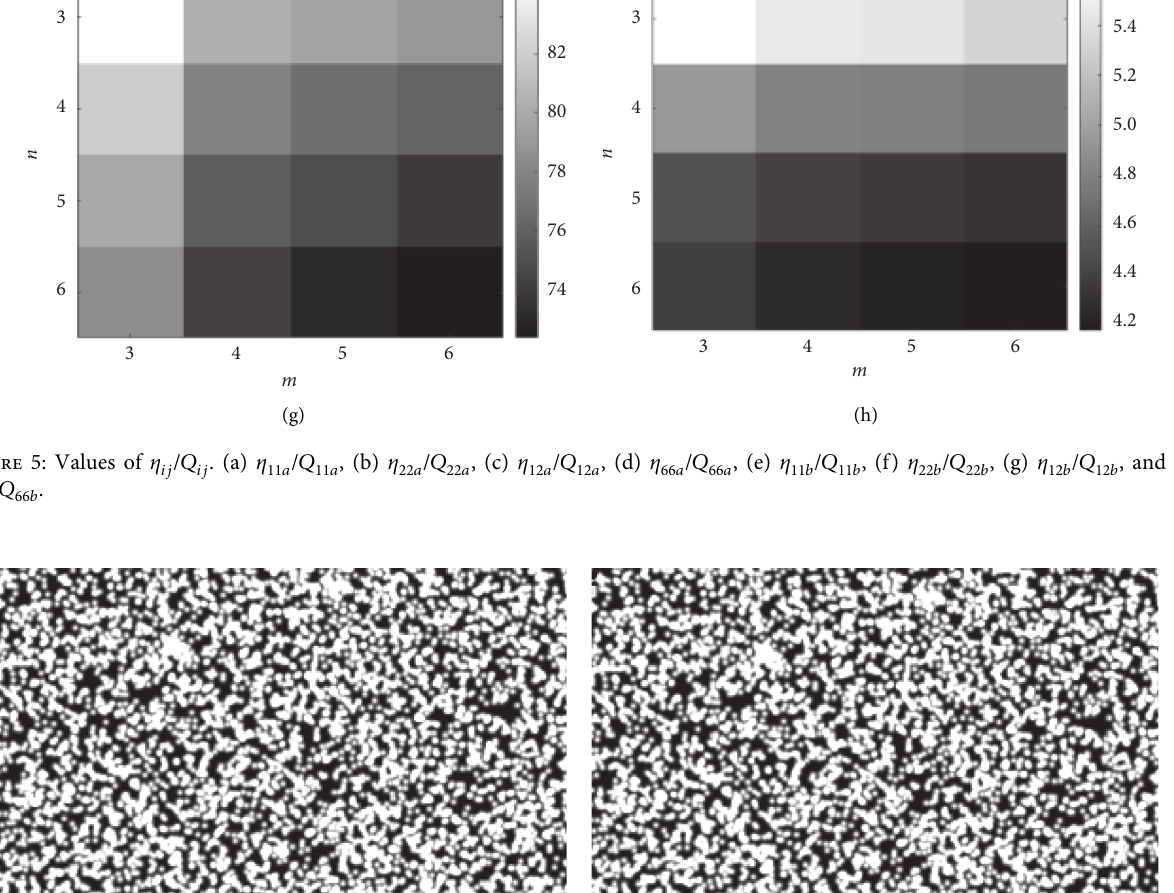
Figure 6: The reference and the deformation speckle pattern images. (a) Reference speckle pattern. (b) Deformed speckle